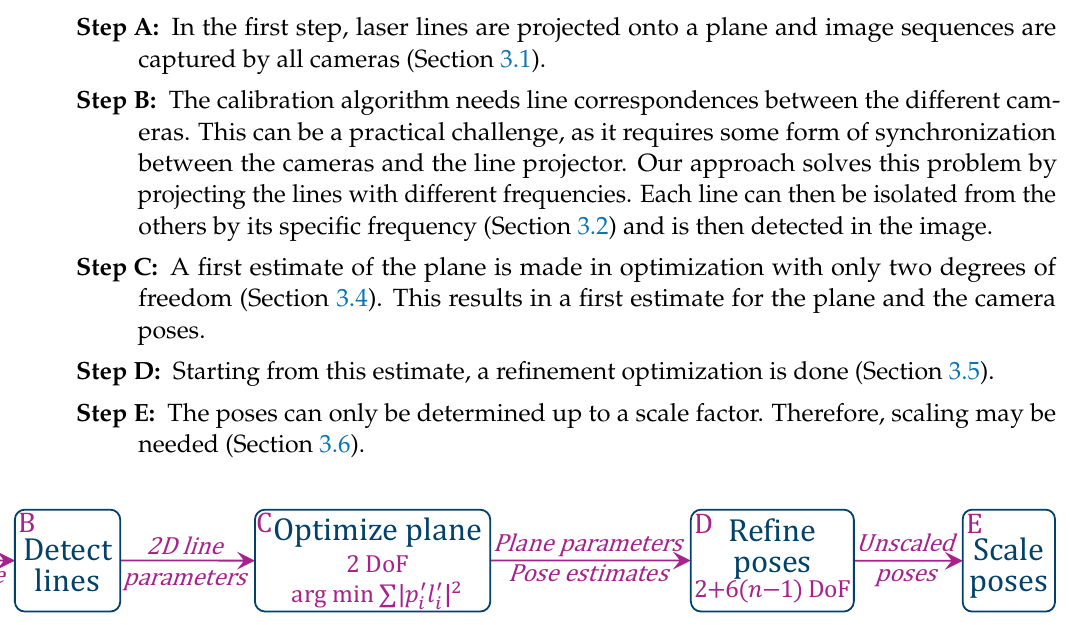
Figure 1. Block diagram of the proposed calibration